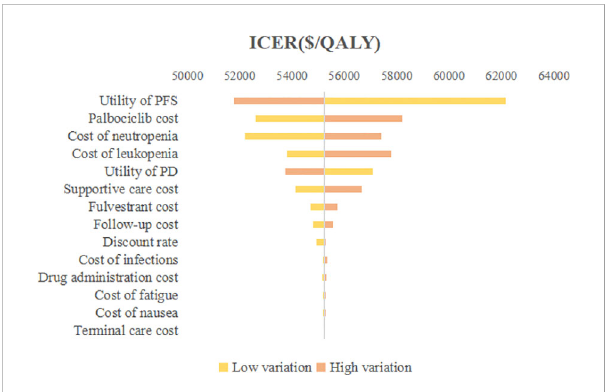
FIGURE 2 Tornado diagram of one-way sensitivity analysis. ICER, Incremental cost-effectiveness ratio; QALY, Quality-adjusted life year; PFS, Progression-free survival; PD, Progressed disease.